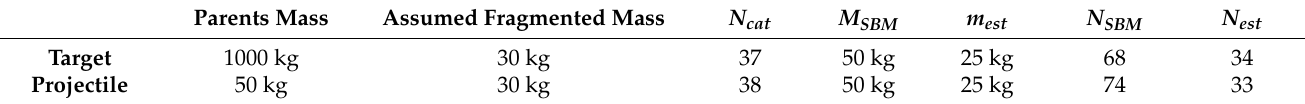
Table 6. Comparison between standard-SBM and iterative-SBM for second test case.